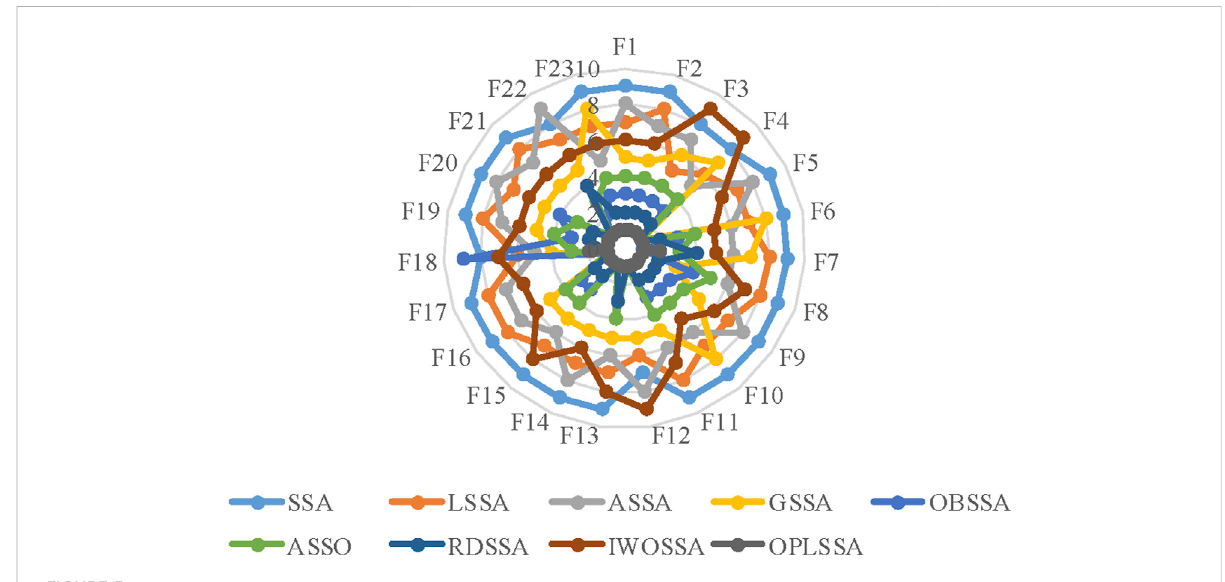
FIGURE 5 Radar plot for consolidated ranks of 23 benchmarkproblems with the SSA